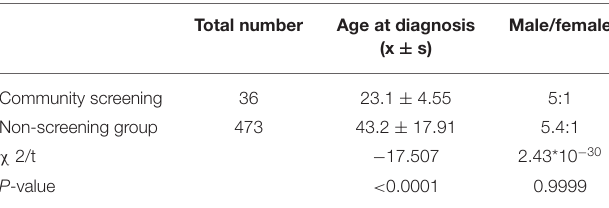
TABLE 2 | Comparison of sex distribution and age at diagnosis between community screening ASD group and non-screening ASD